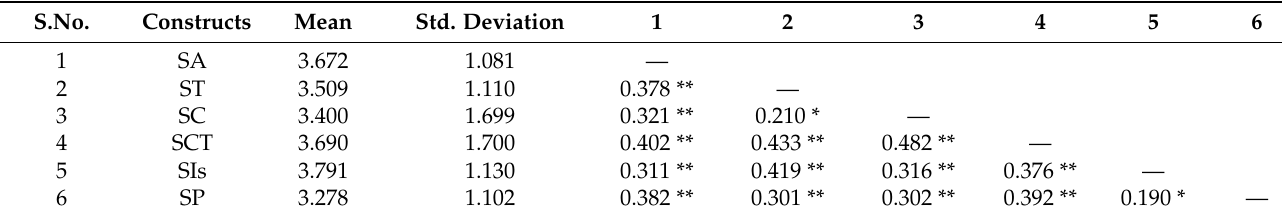
Table 2. Descriptive Statistics and